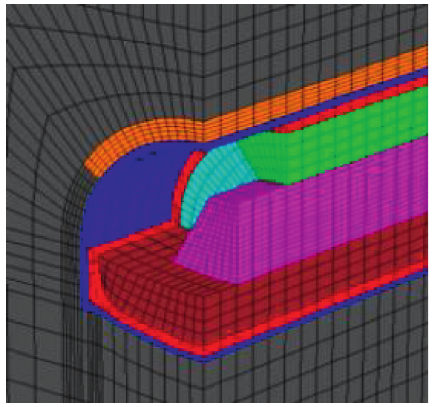
Figure 8: Simulation of the construction method of reserved core